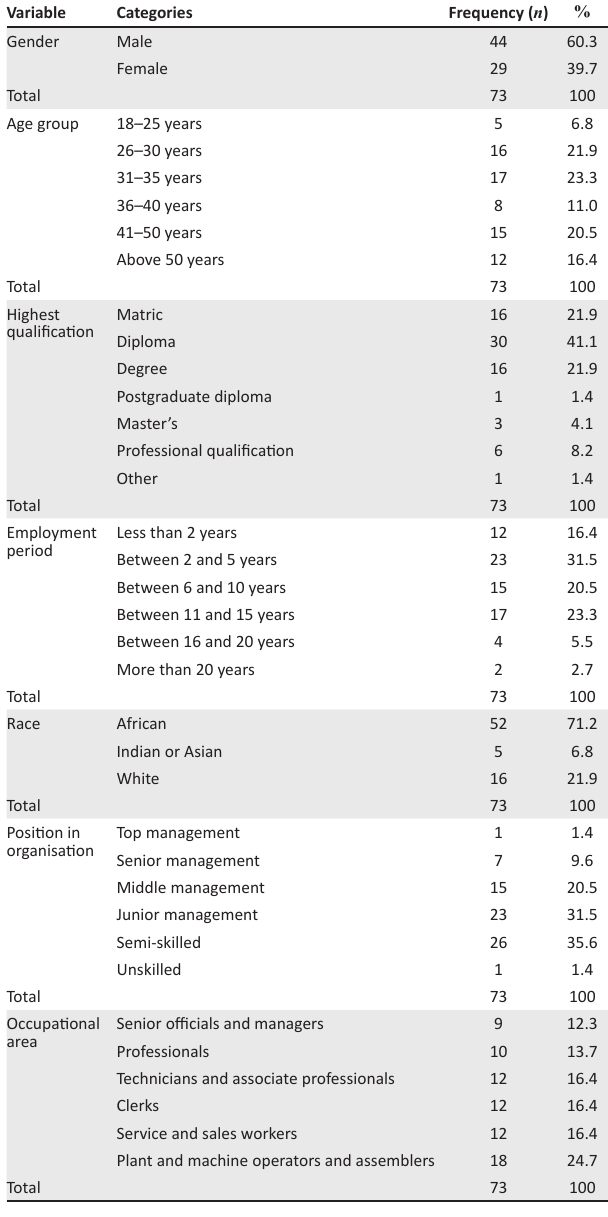
TABLE 1: Demographic details of the